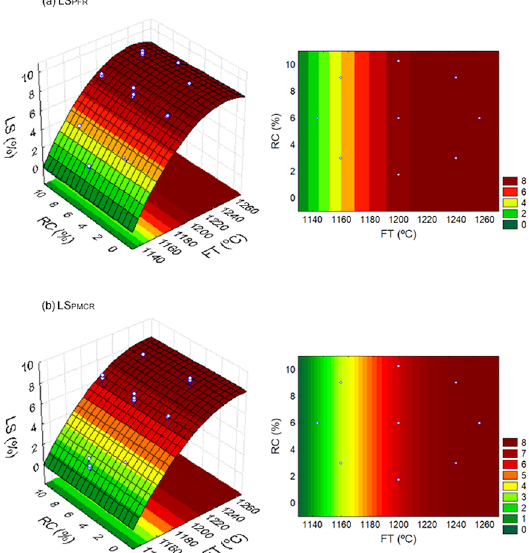
Figure 3. Response surface of the variable LS, for the compositions: (a) PFR and (b) PMCR.